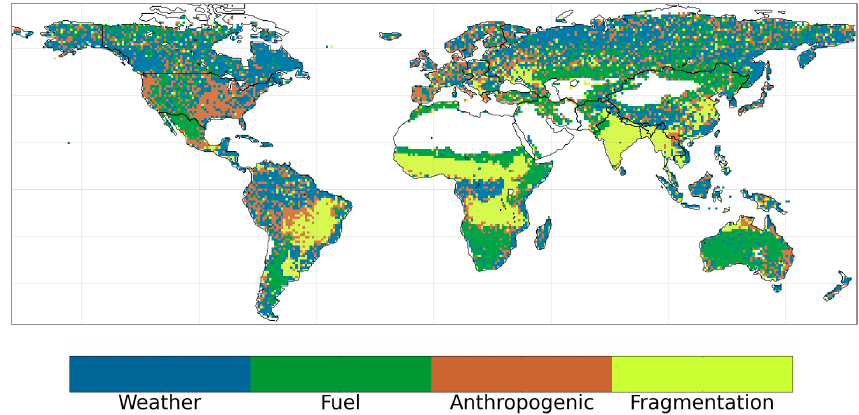
Figure 9. Major drivers of average annual burned area sensitivity among the nine optimized parameters as grouped into four thematic classes (weather, vegetation fuel, anthropogenic practices, landscape fragmentation). For each of the nine parameters, HESFIRE was run keeping the original parameterization, but altering the value of the considered parameter by − 50 and + 50%. The map shows the class of the parameter for which the average burned area in the considered grid cell varied the most between the two runs with these alternative